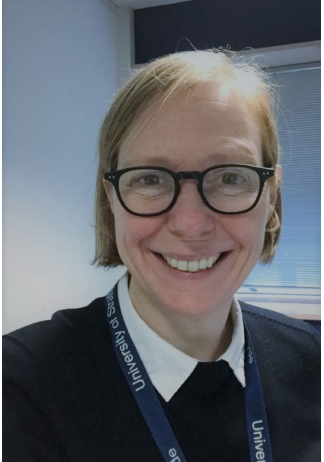
Figure 2. Yvonne